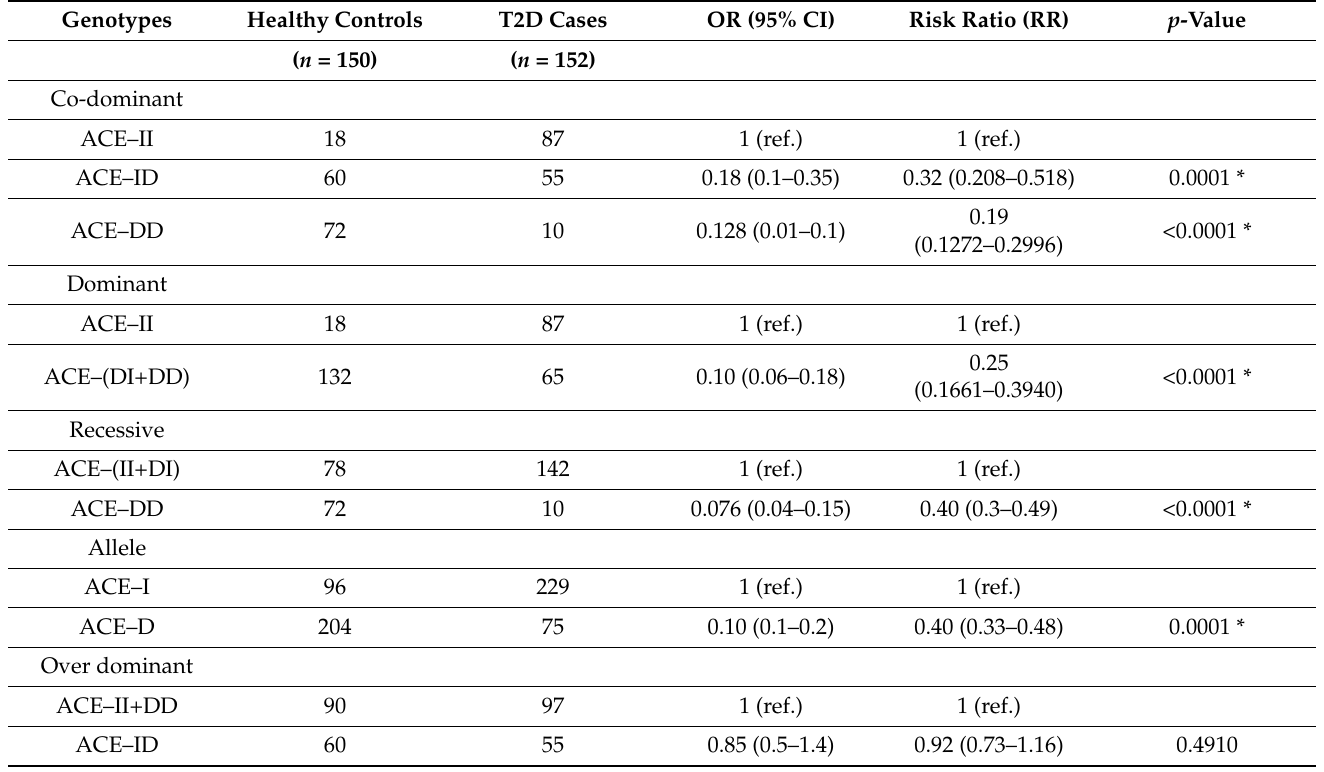
Table 10. Association of ACE I/D polymorphism with T2D.